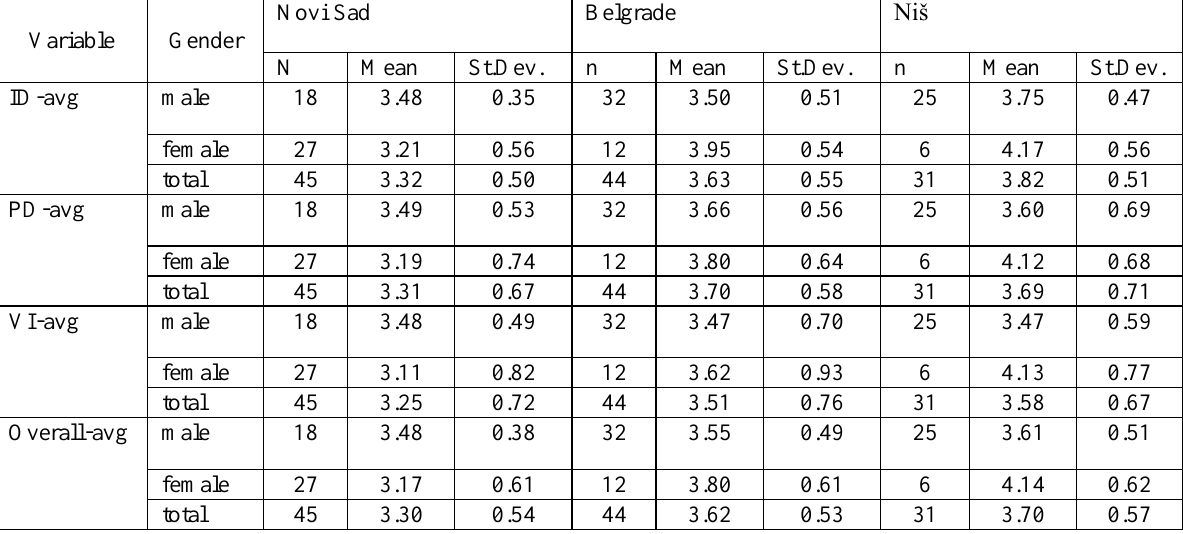
TABLE 1 The level of self-efficacy among PE students from Serbia toward teaching children with disabilities in GPE classes